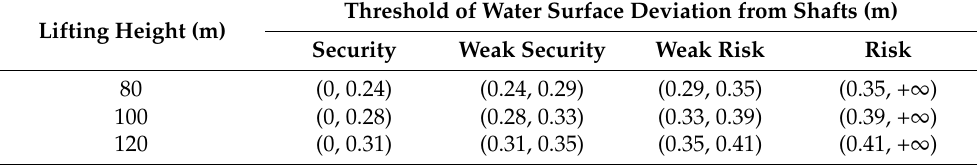
Table 3. Early warning threshold of water surface deviation from the shafts under different lifting heights in the filling–emptying system with an equal inertial pipeline.